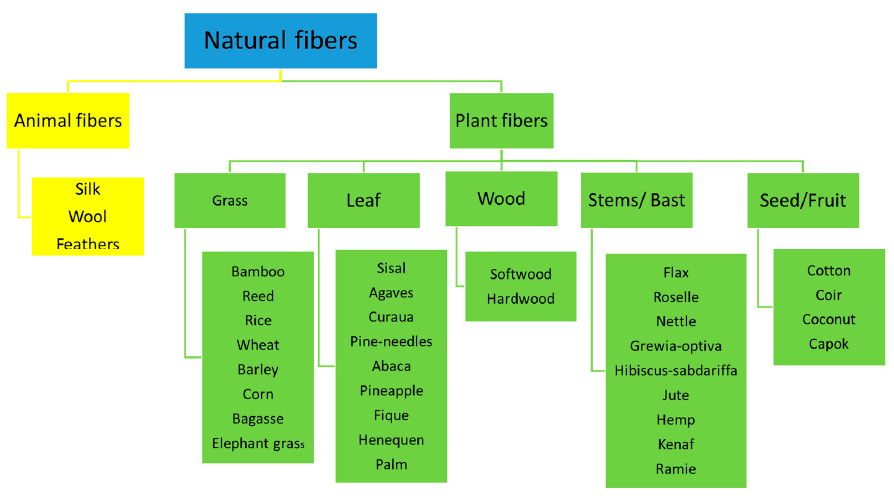
Figure 4. Natural Fiber classifications, adapted from [33,34].